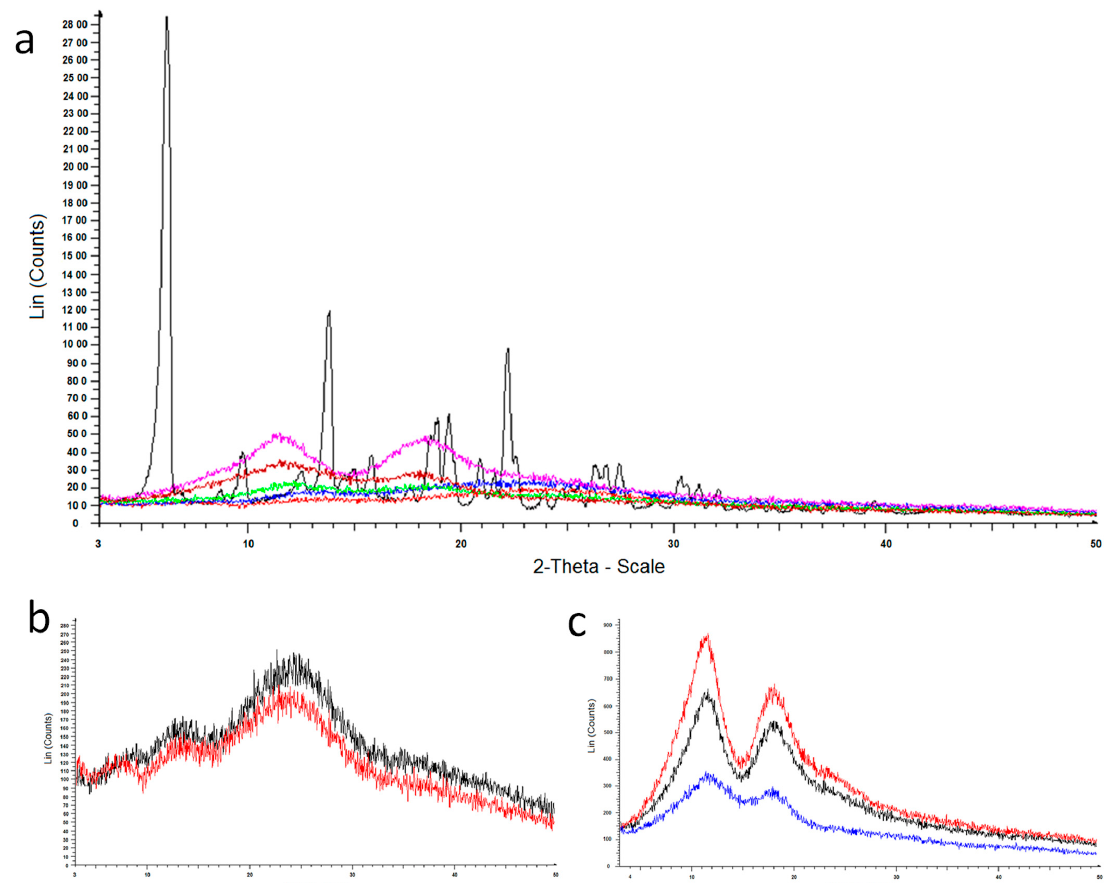
Figure 3. Powder X-ray diffraction patterns of: ( a ) CPA (black), MC90 (brown), MC50 (green) MC10 (blue), MC100 (fuchsia) and CH100 (red); ( b ) chitosan (black) and CH100 (red); ( c ) methyl- β -cyclodextrin (red), MCb (black) and MC100 (blue).